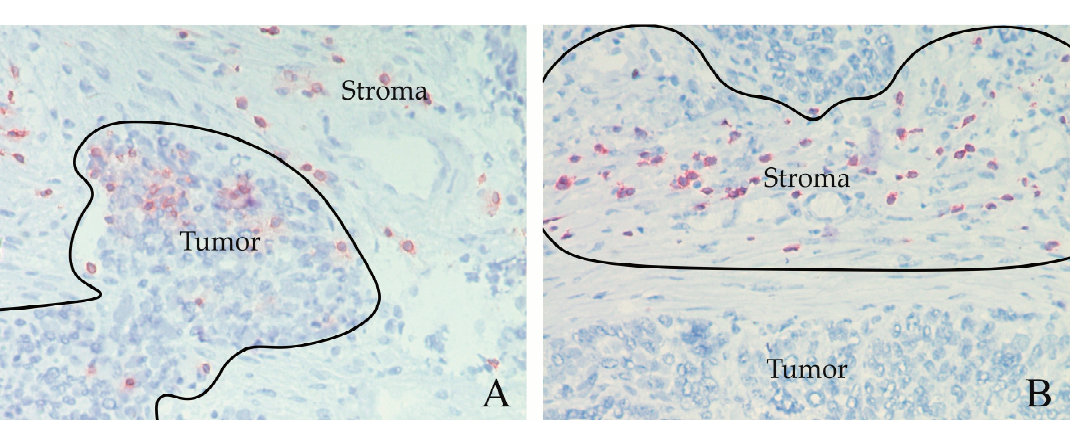
Figure 3 . Immunohistochemical analysis demonstrating intratumoral ( A ) and stromal ( B ) CD3 + cells. The black borders mark the enriched regions, in which CD3 + cells were counted. Tumor and stroma areas are indicated. Magnification 200×.